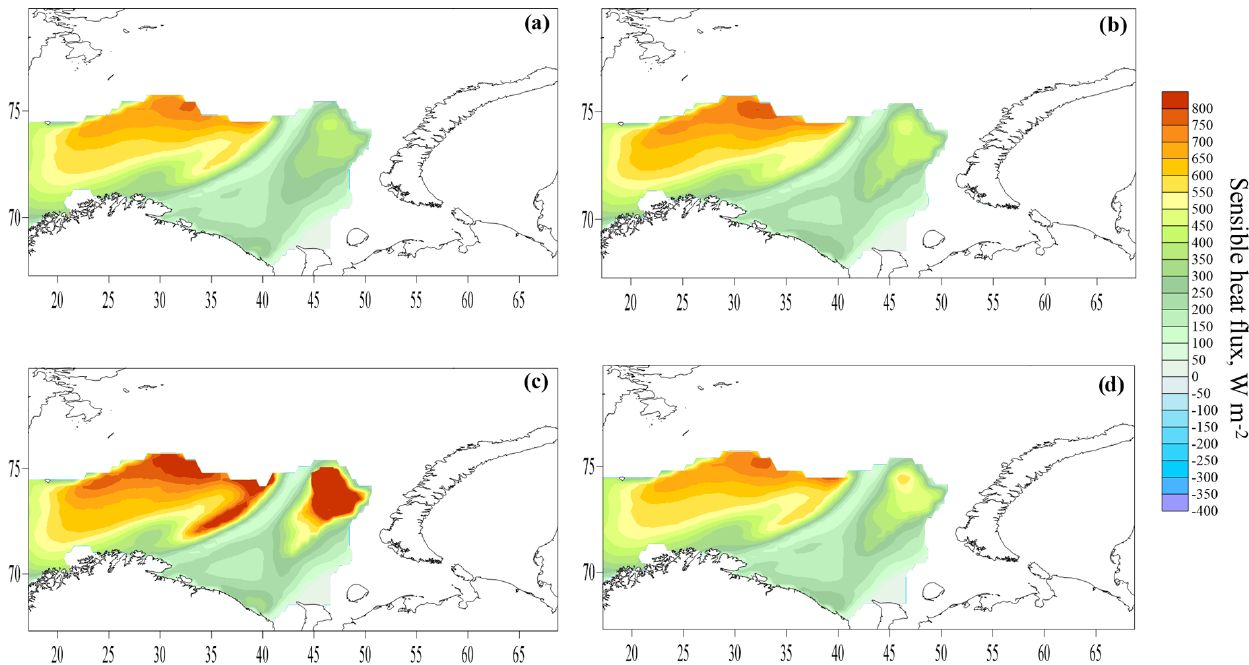
Figure 20. Sensible heat fluxes at 00:00UTC on 13 January 2003 calculated with the C55 (a) , T1 (b) , O2 (c) and D3 (d) parameterizations.